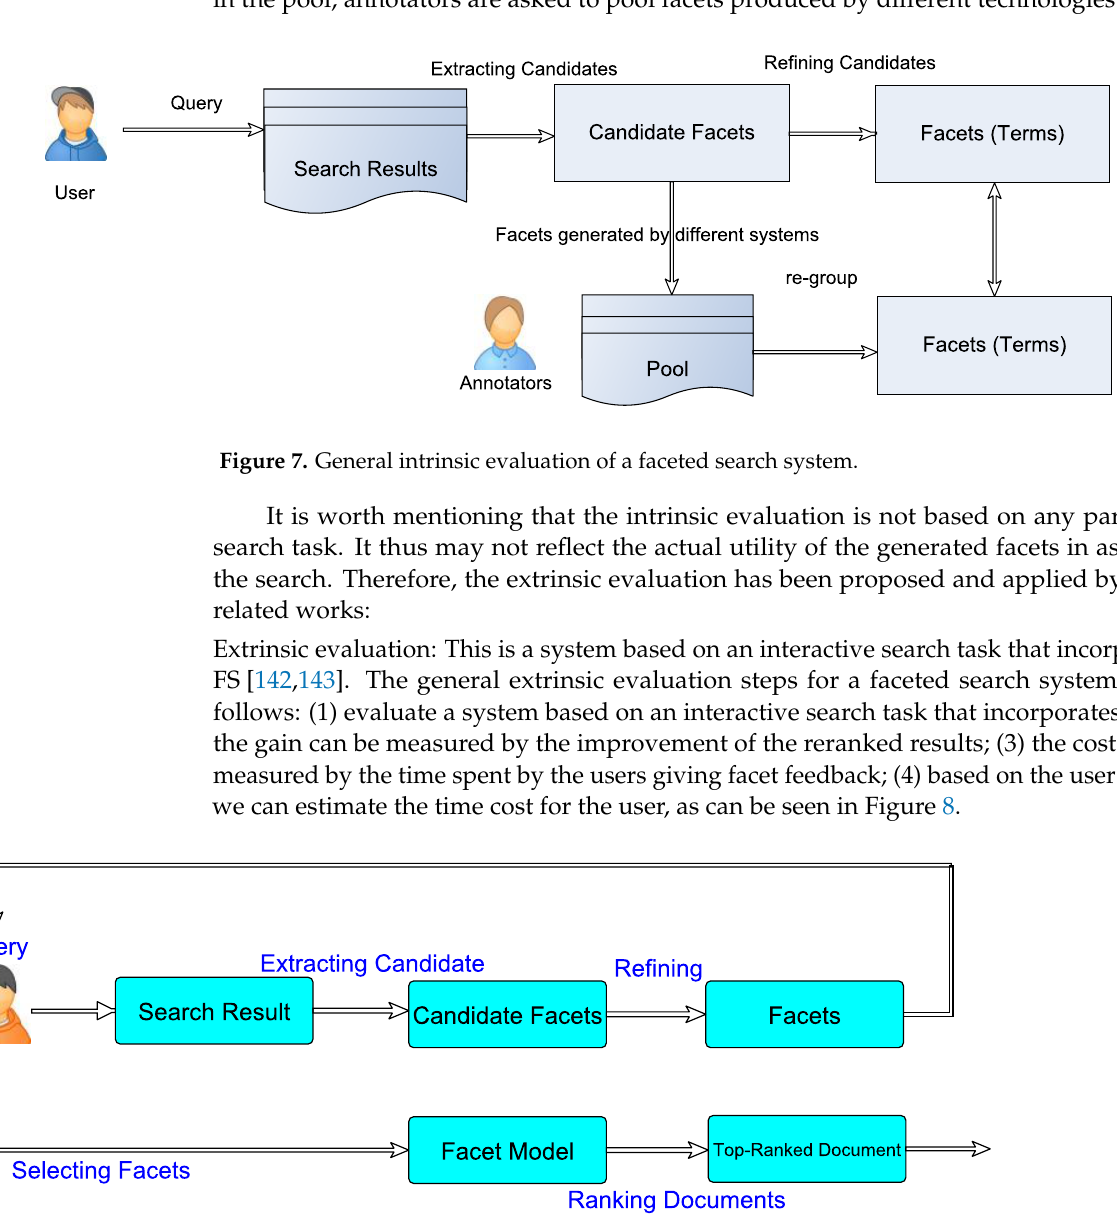
Figure 8. General extrinsic evaluation of a faceted search